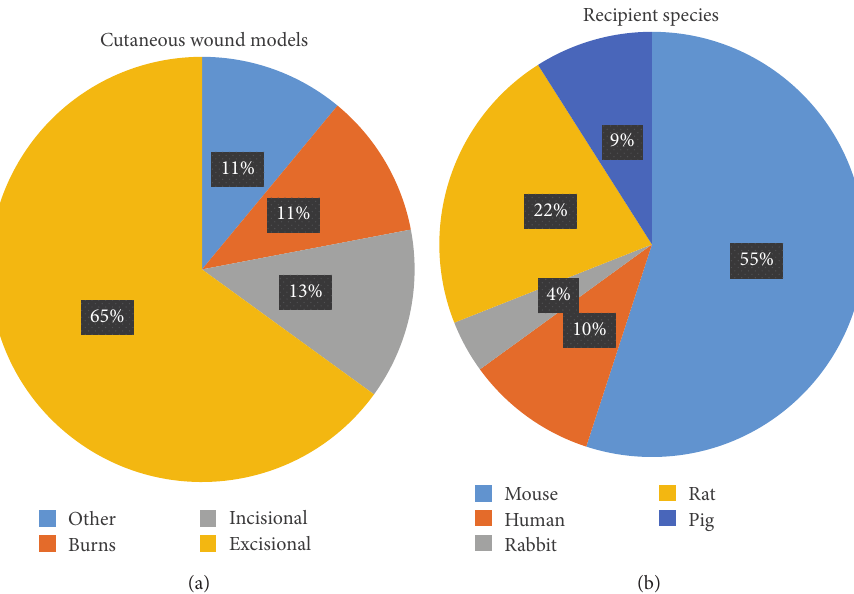
Figure 3: Studies in cutaneous wound healing were performed in a diverse range of animal models. Animal models used for cutaneous wound healing studies are not standardized. (a) Most studies of cutaneous wound healing were performed using excisional wound models in 65% of studies. Other models included incisional wounds and burn models. (b) Most studies were carried out in mouse models (55% of studies) with other models including rat, human, pig, and rabbit